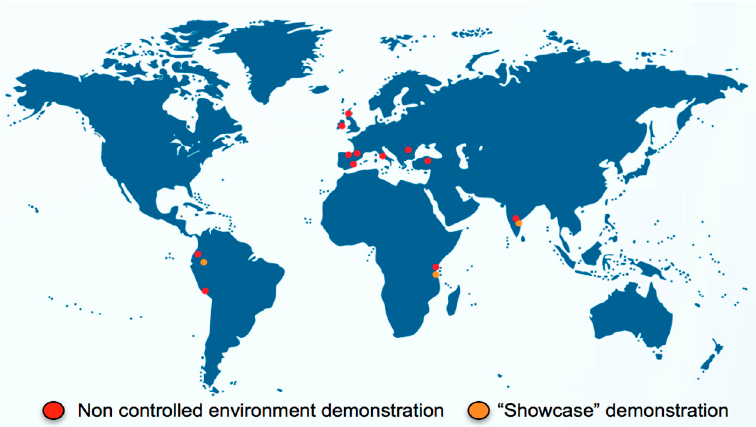
Figure 1. INNOQUA figure developed by the consortium highlighting project demo sites (red points) and showcase sites (orange points) all over the world